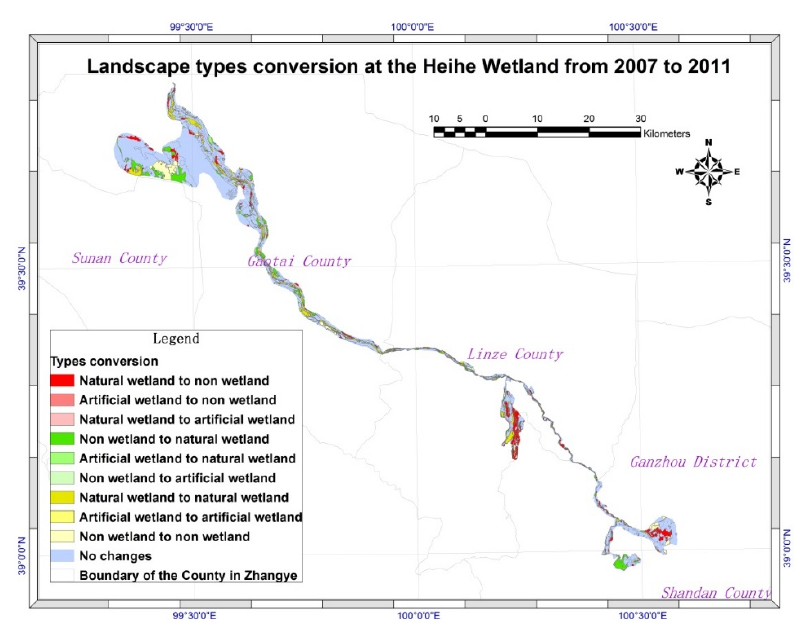
Figure 5. Transition of landscape types during 2007–2011 in the Heihe wetlands. The legend in the figure shows the conversion of different landscape types.